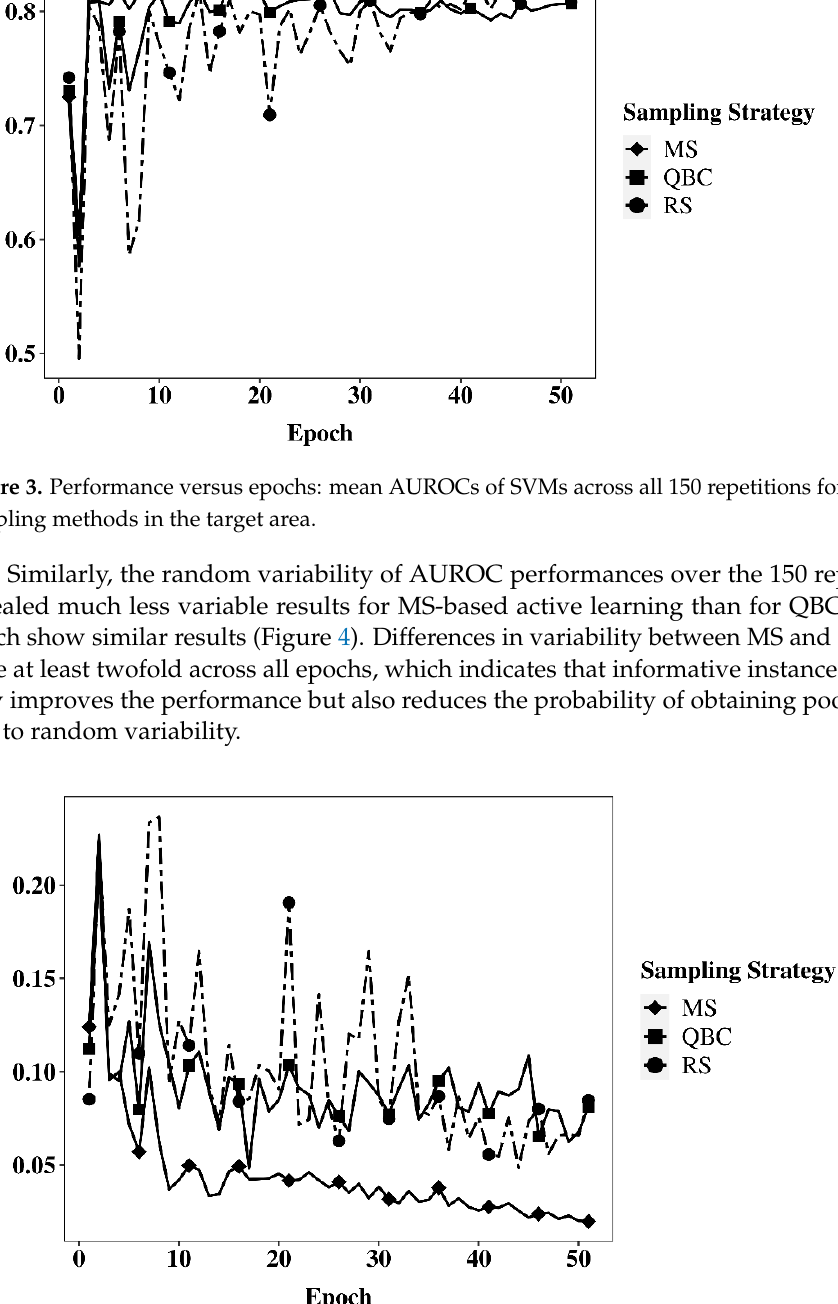
Figure 4. Standard deviation of AUROC estimates across all 150 repetitions for different sampling methods in the target area.